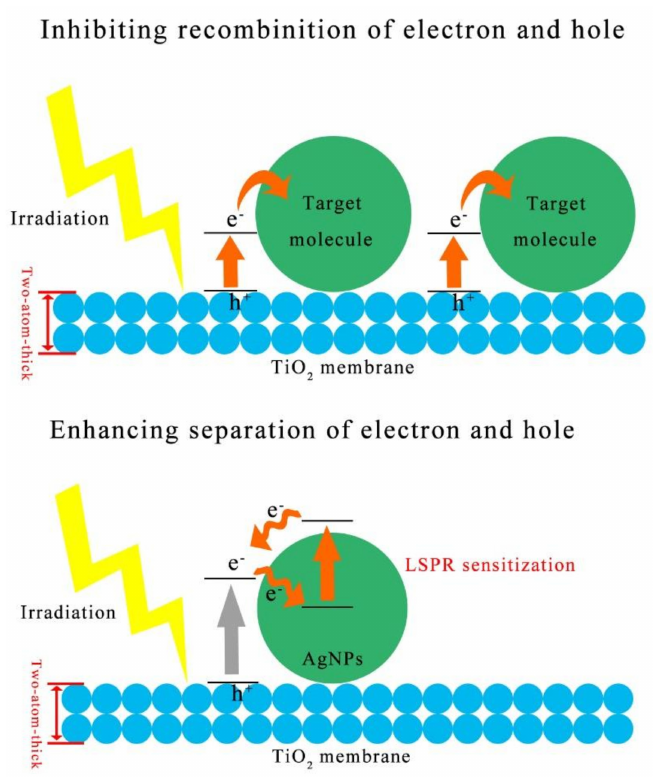
Figure 3. Scheme of the mechanism of inhibiting the recombination of electrons and holes by TiO 2 membranes and enhancing the separation of electrons and